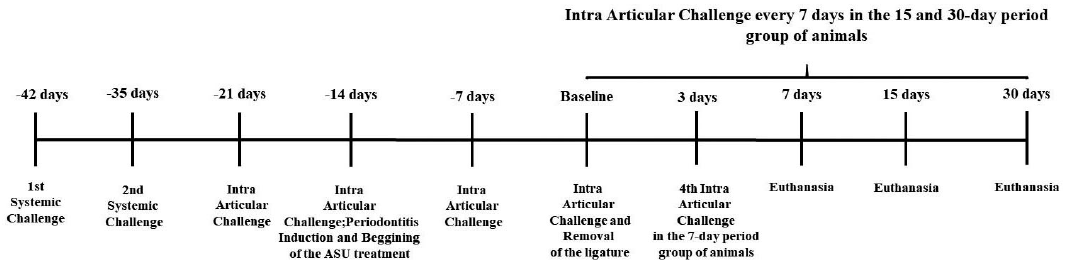
Figure 1- Flowchart of the experiment. Two systemic challenges were achieved with mBSA within 7 days. Fourteen days after the last systemic challenge, the application of the antibody against mBSA within the knee joints was started every 7 days. On the day of the second intra-articular challenge, the induction of periodontal disease was performed by ligatures that were held in place for 15 days. After removing the ligatures, the animals were submitted to euthanasia at 7, 15 and 30